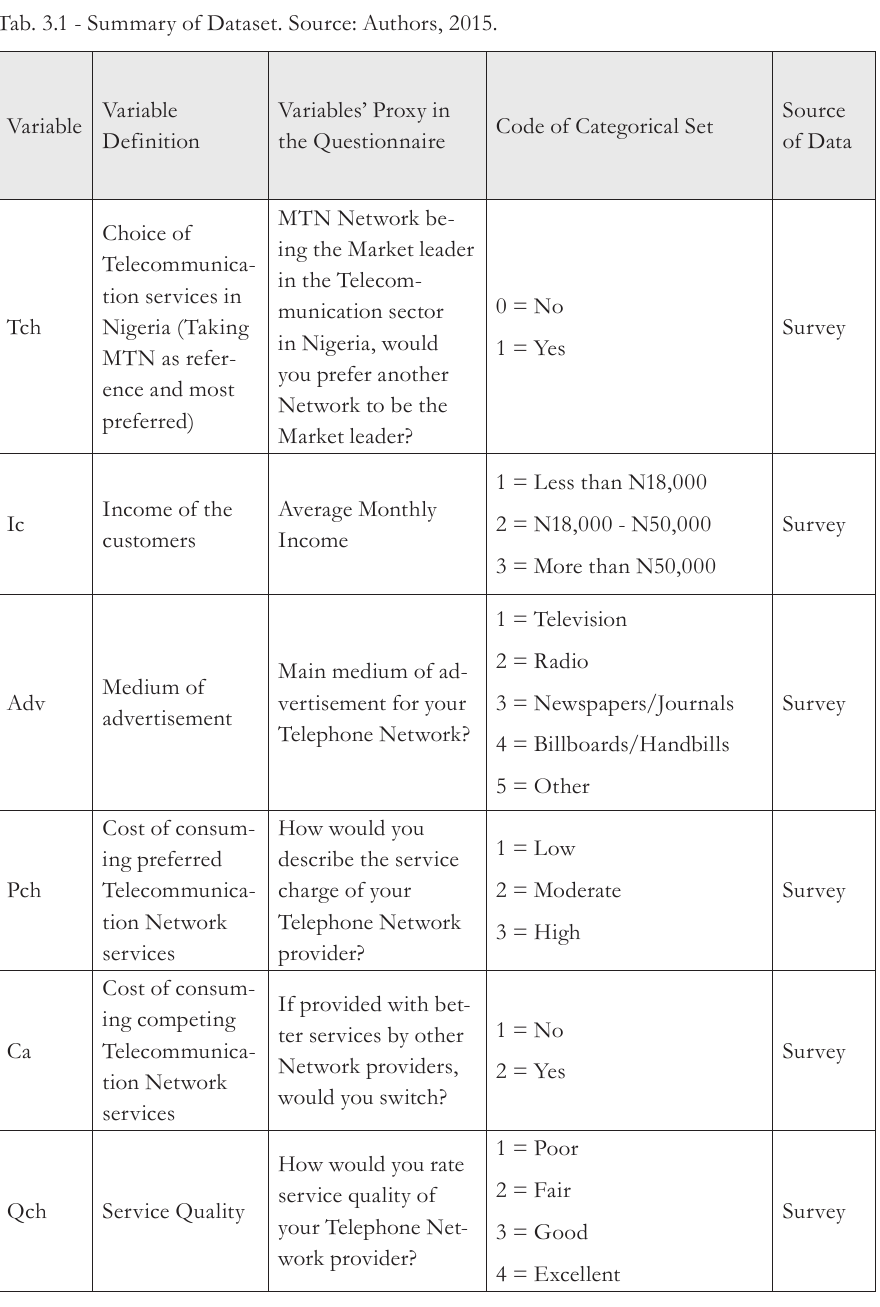
Tab. 3.1 - Summary of Dataset. Source: Authors,